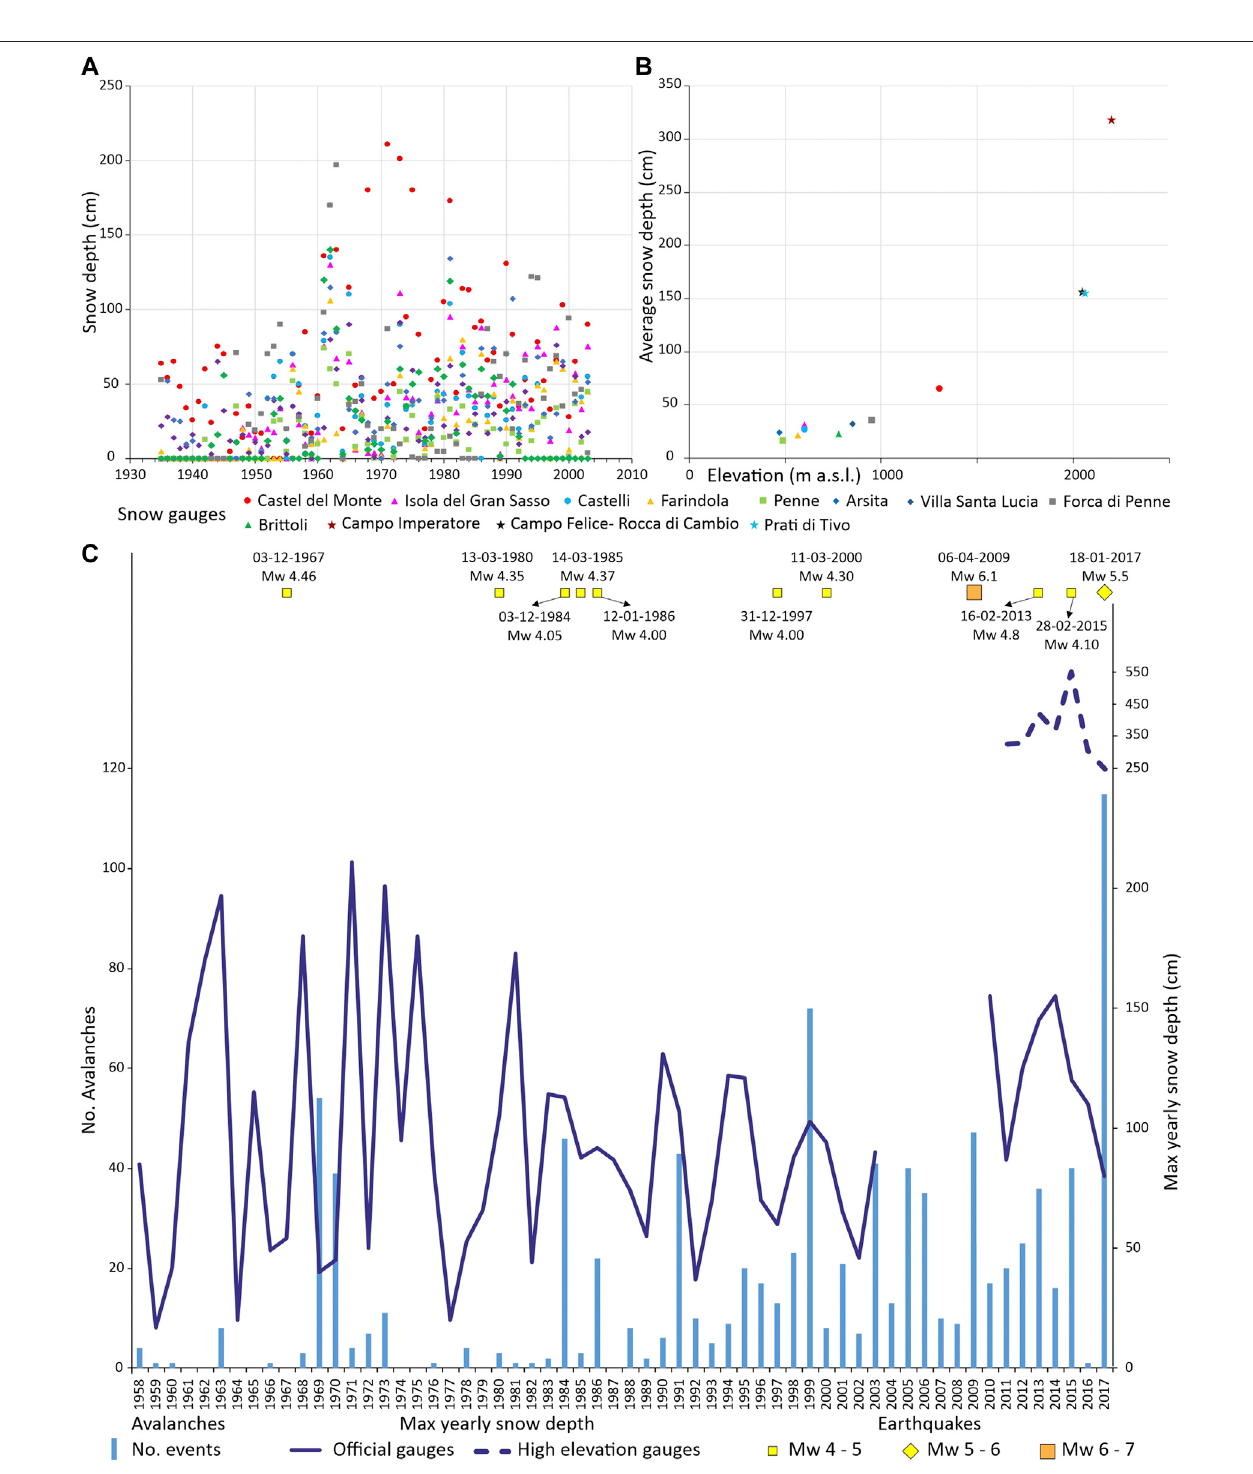
FIGURE3 |(A) Snow coverdistribution inthe Gran Sasso area (snow gaugesand locations in Table 1 and Figure 2b ).For each site and each year, the maximum snow depth wasderived and plotted. The record period is1935to2003(ISPRA,2018). (B) Theaverage snow depthvs. snow gauges elevation intheGran Sasso area. For each site and each year, the average maximum snow cover was derived and plotted. (C) The number of avalanches in the Abruzzo region from 1957 to 2017 (Regione Abruzzo, 2014), compared to the maximum snow cover recorded at all the snow gauges ( Table 1 ) and to the main seismic sequences or moderate earthquakes (Mw > 4) occurring in